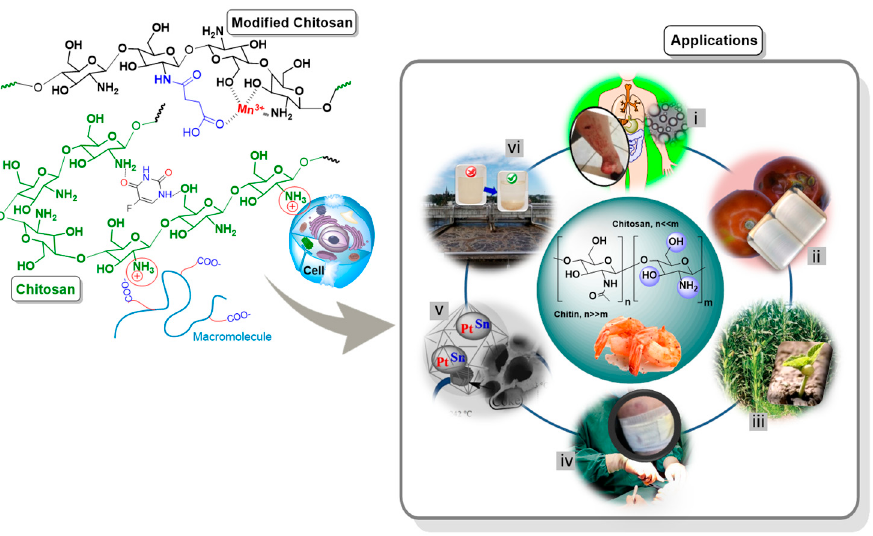
Figure 1. Scheme related to the interaction of the chitosan backbone with small molecules, macromolecules, cell, and inorganic substances, as well as the different applications such as issues in medicine (i), postharvest conservation and food packaging (ii), agriculture (iii), (cosmeto-)textile industry (iv), catalysis (v), and water treatment (vi).